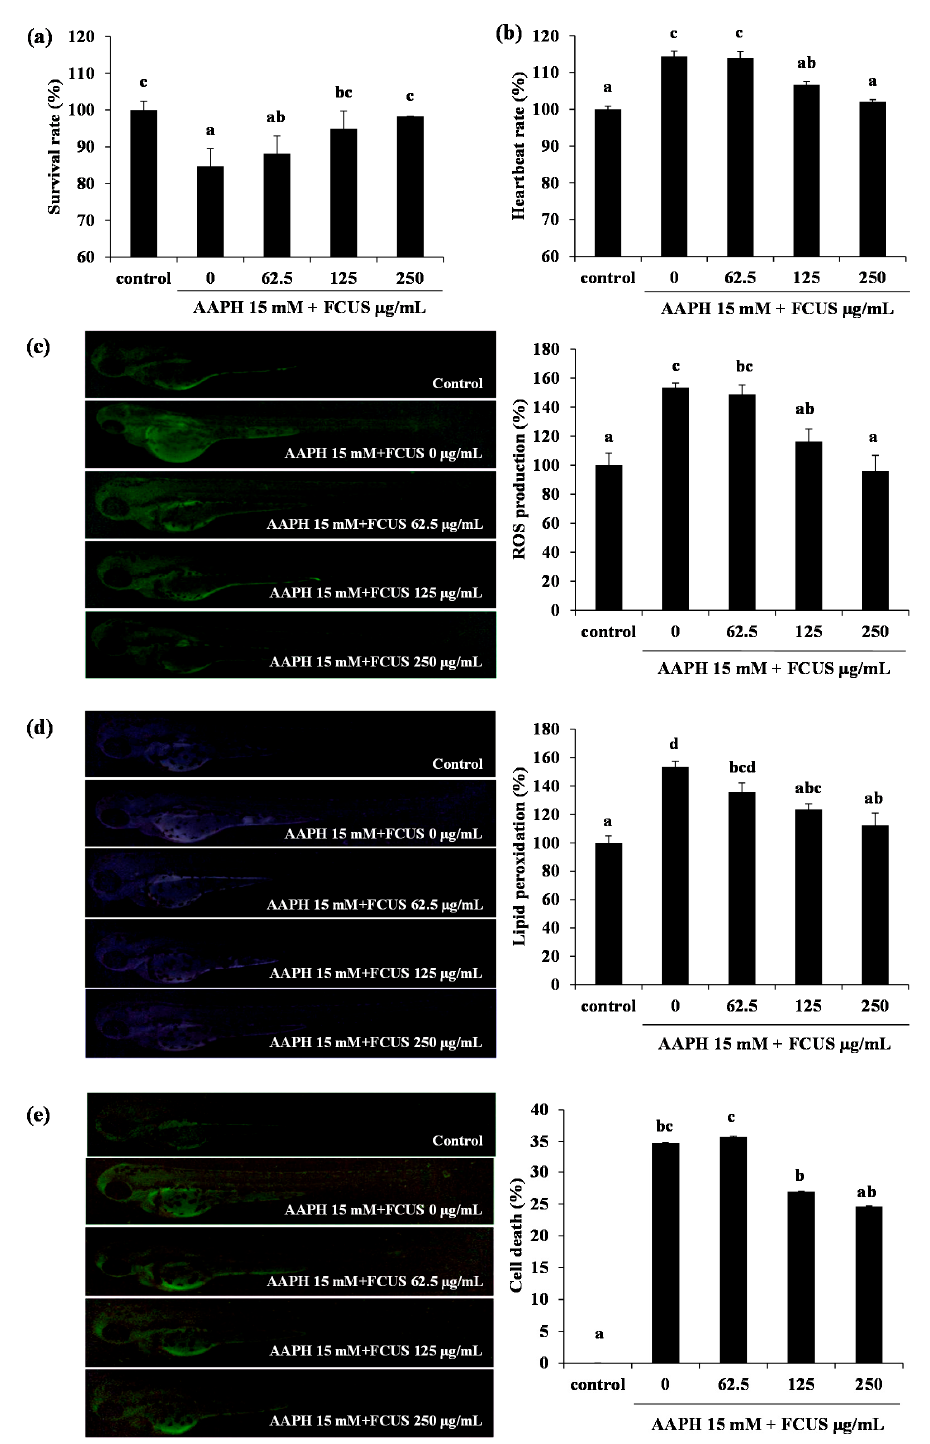
Figure 3. E ff ects of FCUS on the survival rate ( a ), heartbeat rate ( b ), reactive oxygen species (ROS) production ( c ), lipid peroxidation production ( d ), and cell death ( e ) in AAPH-treated zebrafish. Production of ROS, lipid peroxidation, and cell death were measured by fluorescence microscopy and analyzed using ImageJ software. Each value is expressed as the mean ± SE. a–d Means not sharing a common letter are significantly di ff erent between groups ( p <